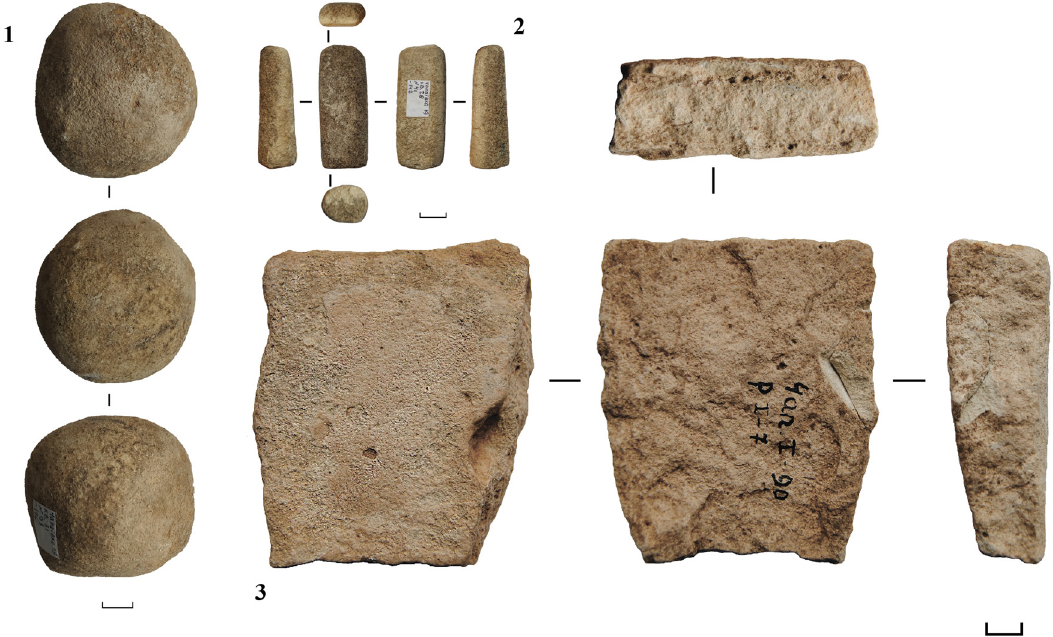
Figure 4: Sandstone items from Chapaevka. 1 – a round hammerstone ( ⌀ 54 – 56 mm ) , 2 – a grindstone ( 50 × 18 × 10 mm ) , 3 – a big piece of coquina with traces of